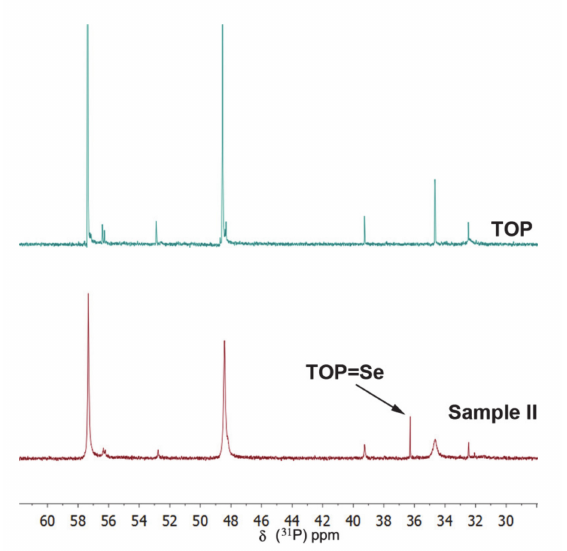
Figure 4. 31 P NMR analysis of reaction intermediates during the reaction of FeSe 2 with TOP. The top spectrum corresponds to standard TOP. The bottom spectrum corresponds to Sample II, taken from the crude reaction mixture by J. Young NMR tube.